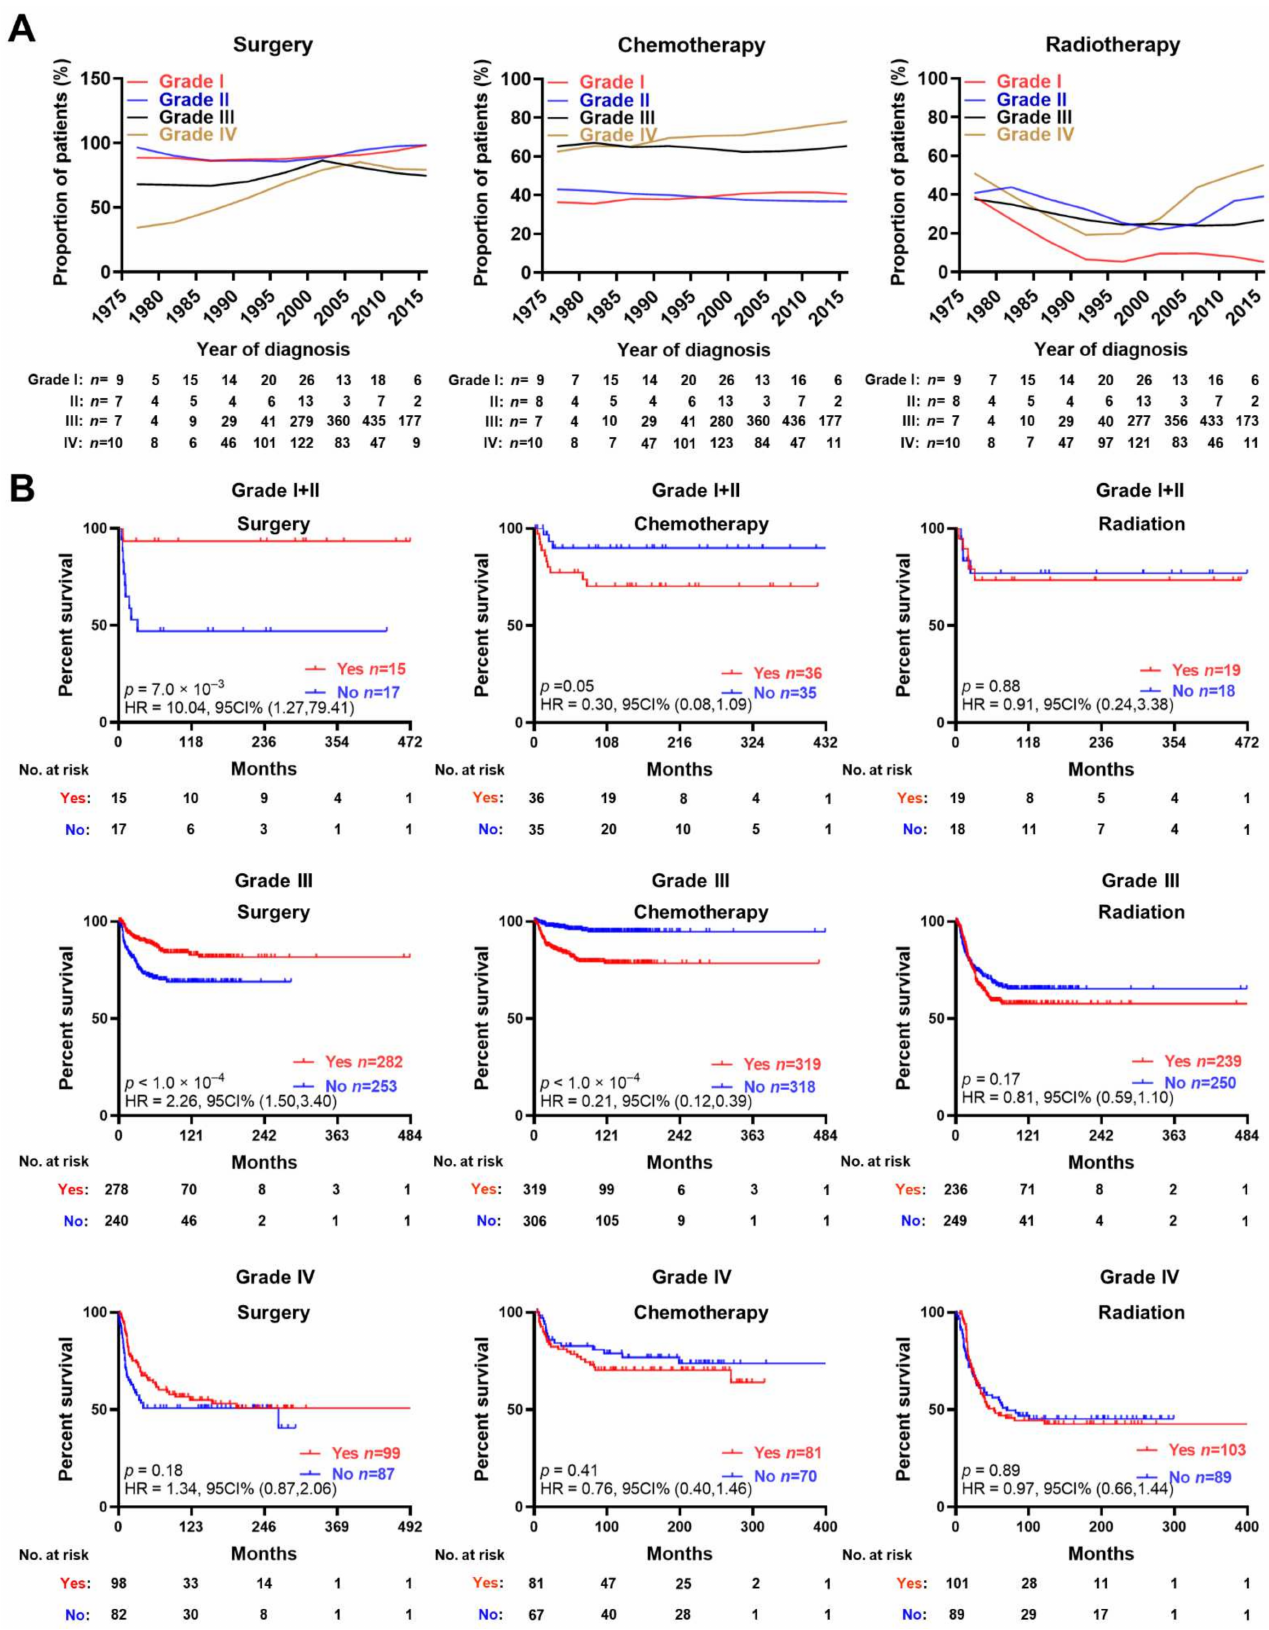
Figure 2. Trends and effects of surgery, chemotherapy, and radiotherapy. ( A ) Proportion of neu- roblastoma patients with different histopathological grades undergoing surgery, chemotherapy,